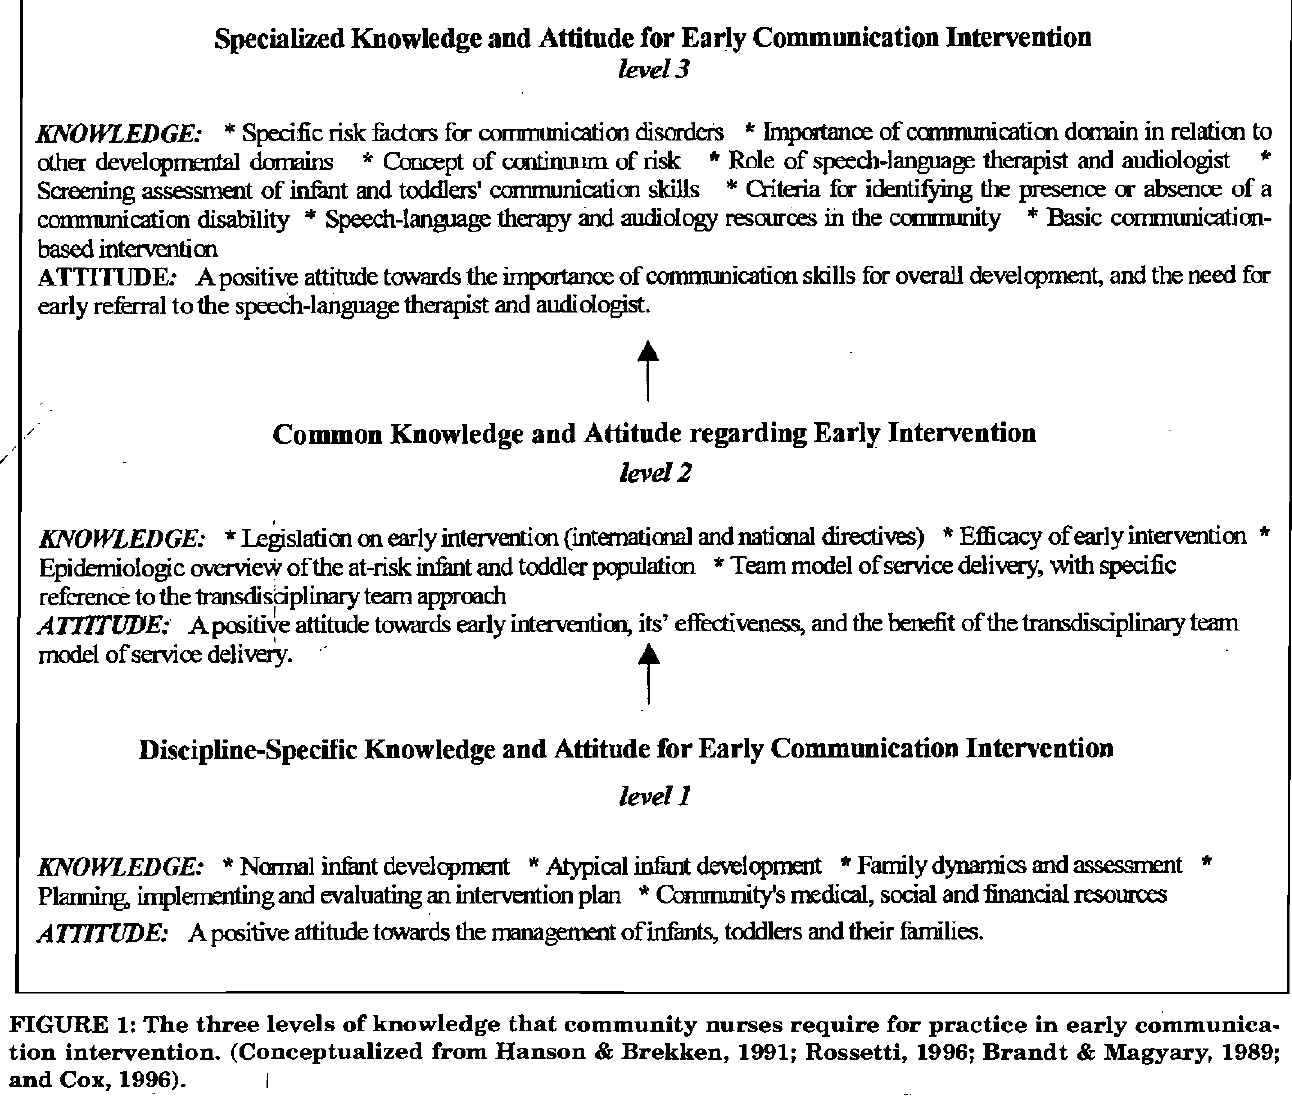
FIGURE 1: The three levels of knowledge that community nurses require for practice in early communica- tion intervention. (Conceptualized from Hanson & Brekken, 1991; Rossetti, 1996; Brandt & Magyary, 1989; and Cox,